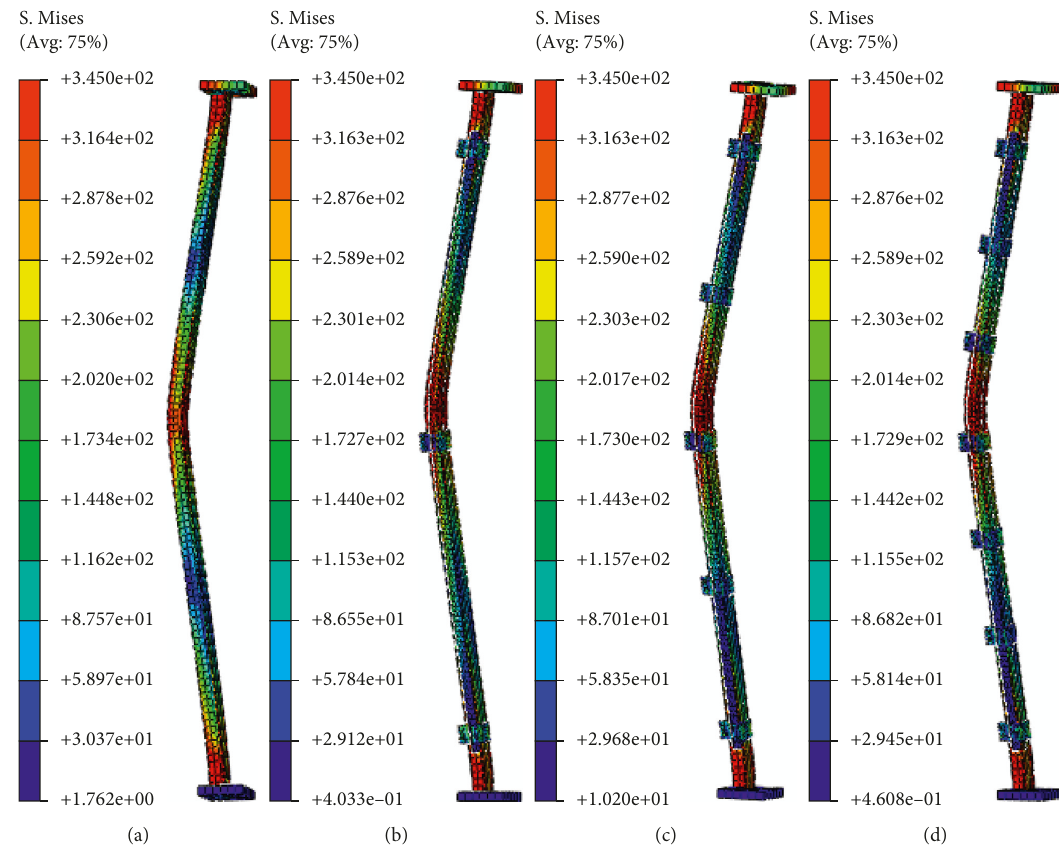
Figure 10: Member buckling shapes (L140 × 14mm). (a) L140 × 14G0SR75-0. (b) L140 × 14G76SR75-1712. (c) L140 × 14G76SR75-855. (d) L140 ×